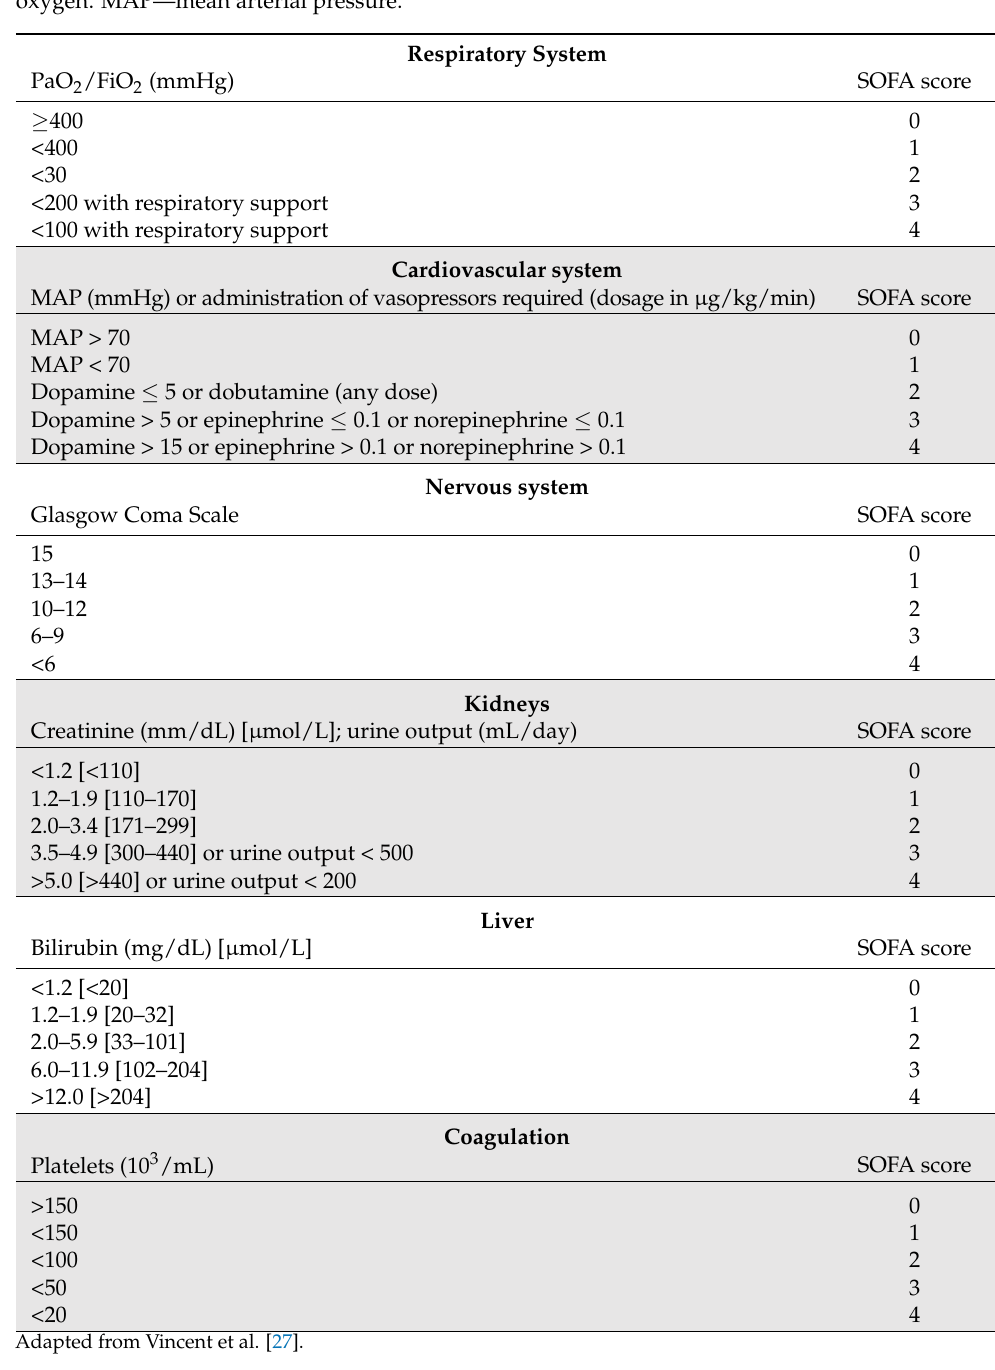
Table 1. The SOFA score. PaO 2 —partial pressure of oxygen in the blood. FiO 2 —fraction of inspired oxygen. MAP—mean arterial